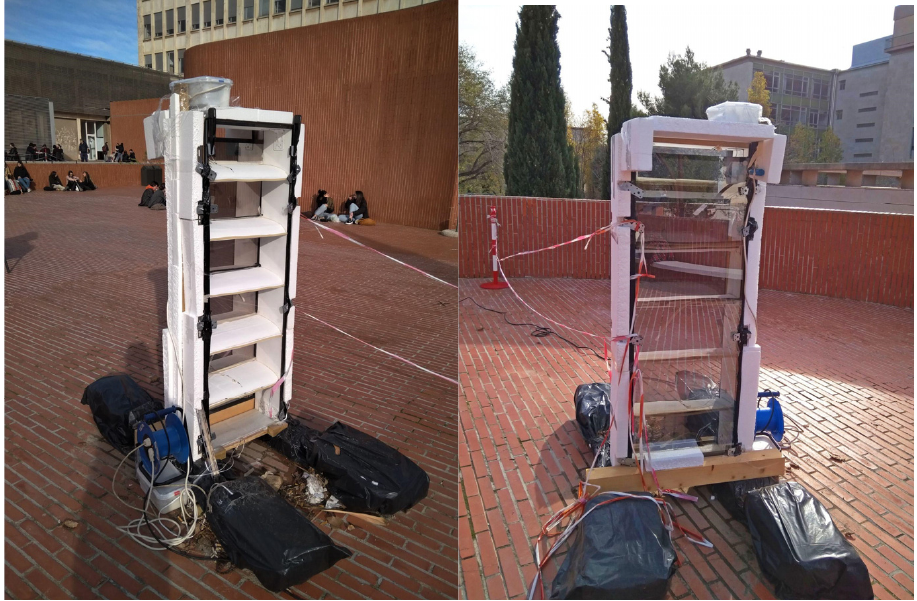
Figure 2. Model installed at the testing site. Table 1. Physical characteristics of the model’s envelope materials. Source: provided by Ariño Duglass [40] and from CTE [41].